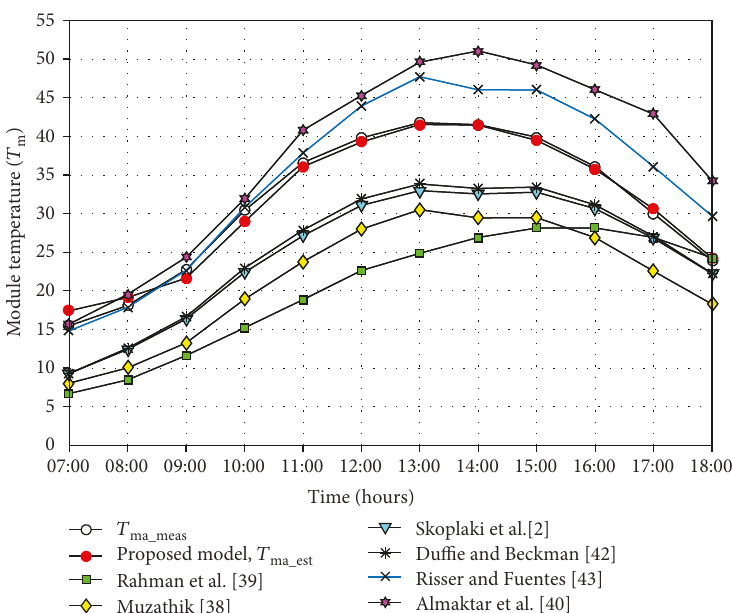
Figure 10: Proposed model estimation versus measured data and other existing model module temperature values of amorphous module during winter.